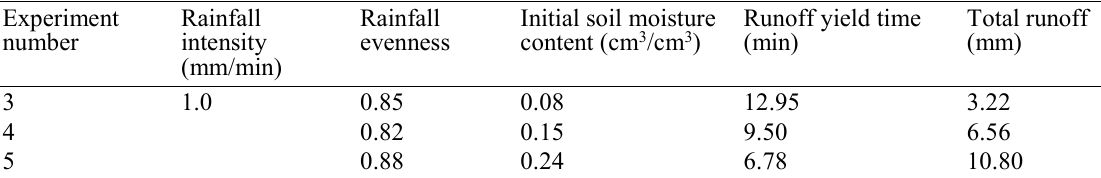
Table 2 Rainfall infiltration, runoff cases in runoff plots under initial soil moisture content. Experiment number